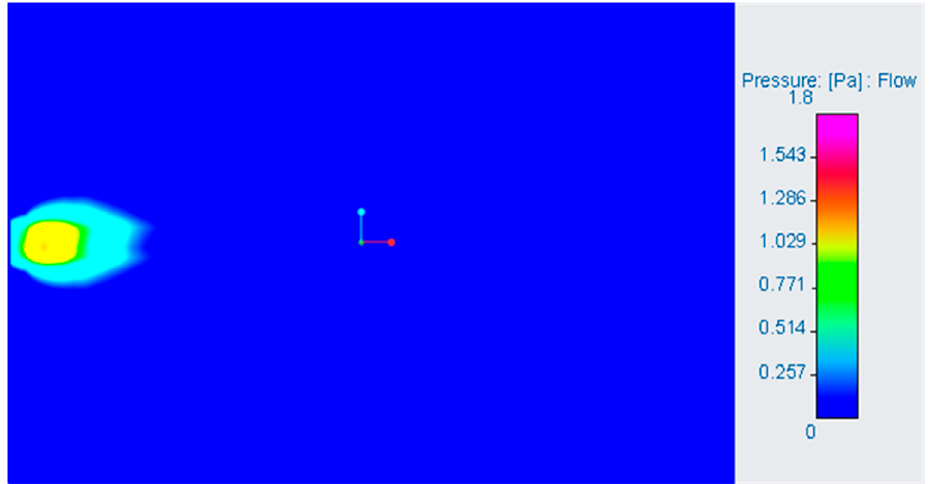
6 of 17 Table 1. Simulation parameters. Simulation Parameters